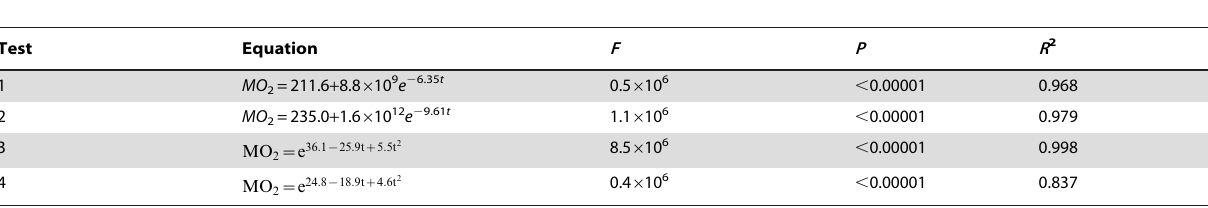
Table 3. Variation of oxygen consumption rate over time during the recovery